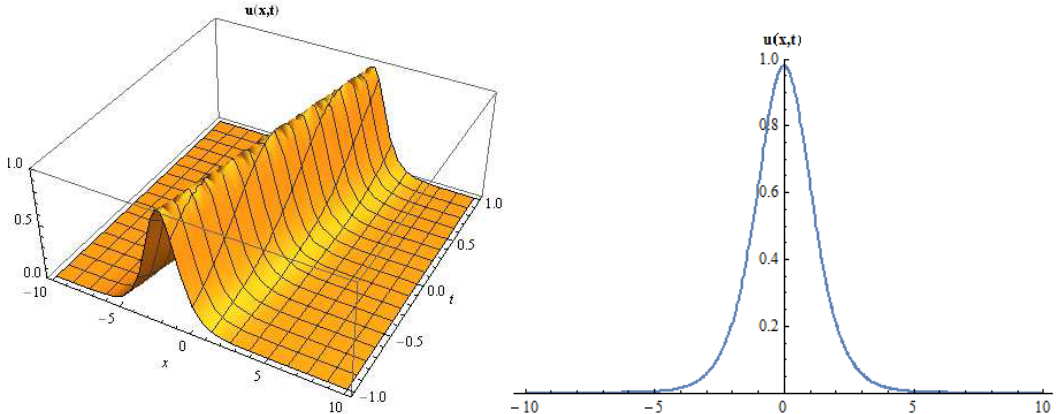
Fig. 2 The 3D and 2D surfaces of Eq. (16).